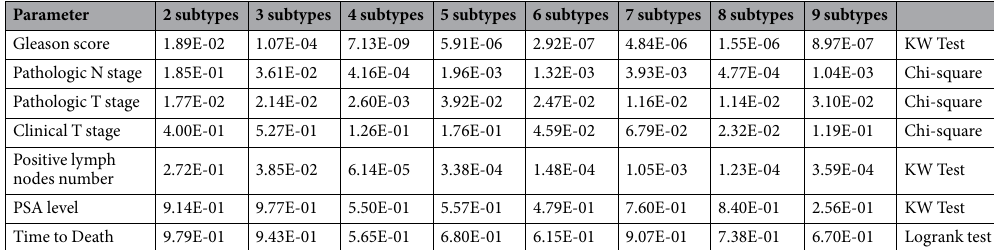
adenocarcinoma. To investigate the differences in PSA level among patients in different k molecular subtypes, sta- tistical analysis was performed. The statistical analysis using nonparametric Kruskal-Wallis tests failed to demon- strate a significant association between the subtypes and the PSA level (Table 2), suggesting that this feature is independent of the molecular subtype. Survival of prostate adenocarcinoma patients with respect to subtypes. Next, we investigated the association between subtypes and survival. The median patient ages and follow-up times are shown in Table 1. As shown in this table, the median overall patient age was 61 years (range, 41–78 years), the median overall follow-up time was 512 days (range: 1 to 4602 days), and only 8 patients died of prostate adenocarcinoma. To further inves- tigate the clinical relevance of the molecular subtypes, a Kaplan-Meier Survival analysis on the 498 samples was